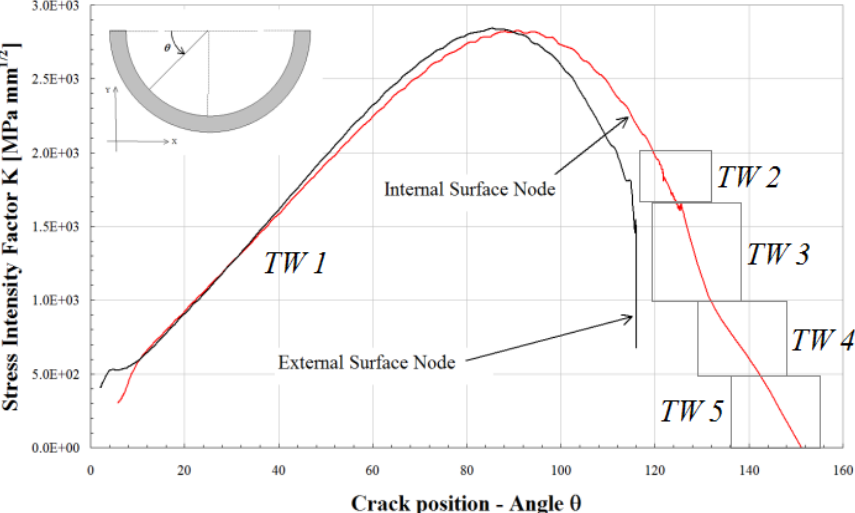
Figure 21: Comparison of overall K curves for internal and external surface